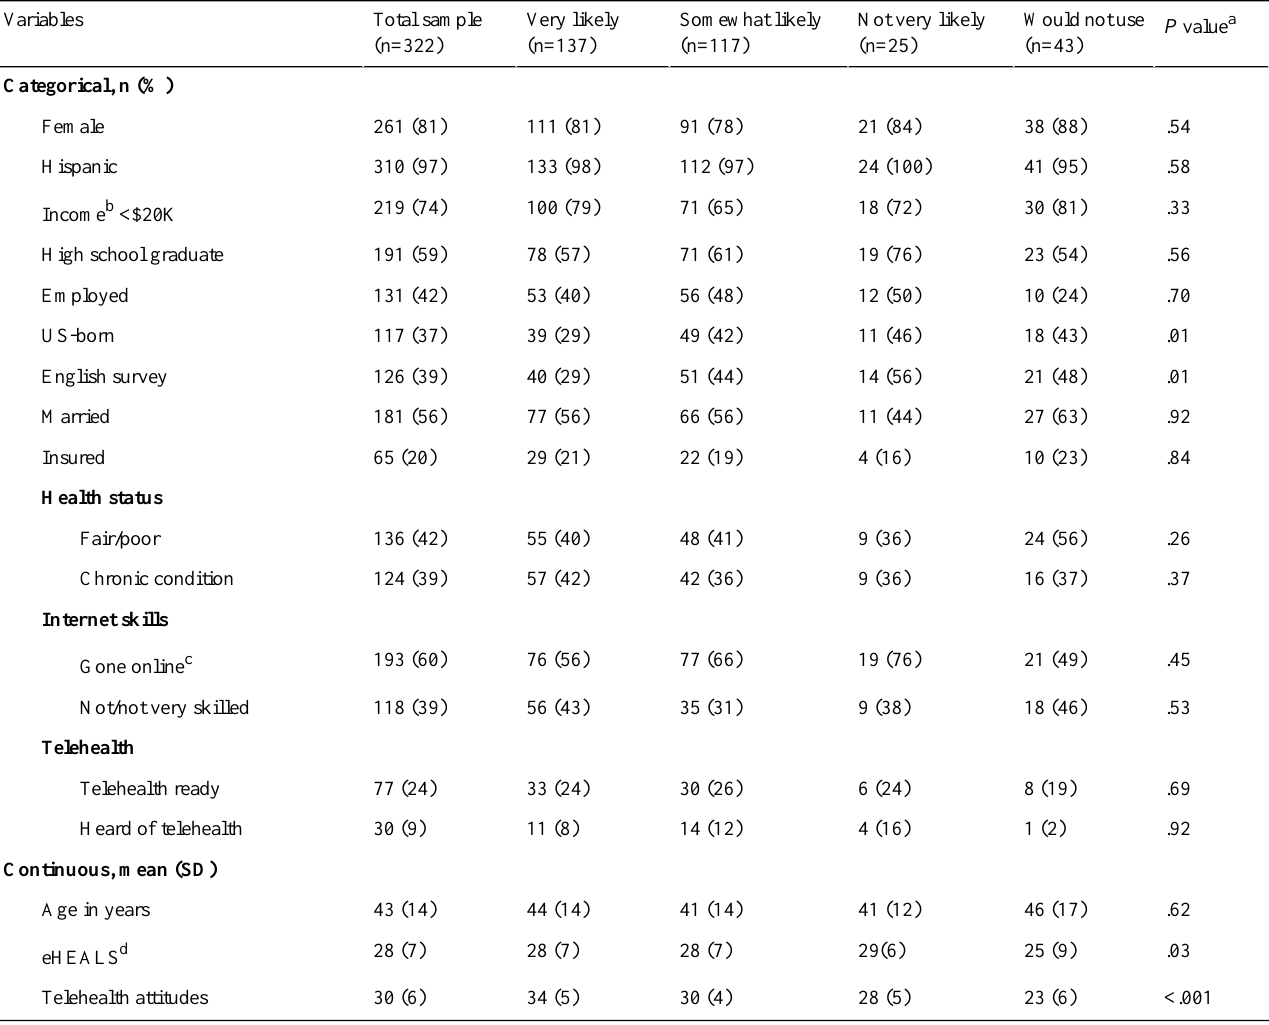
P value a Would not use (n=43)Not very likely (n=25)Somewhat likely (n=117)Very likely (n=137)Total sample (n=322)Variables